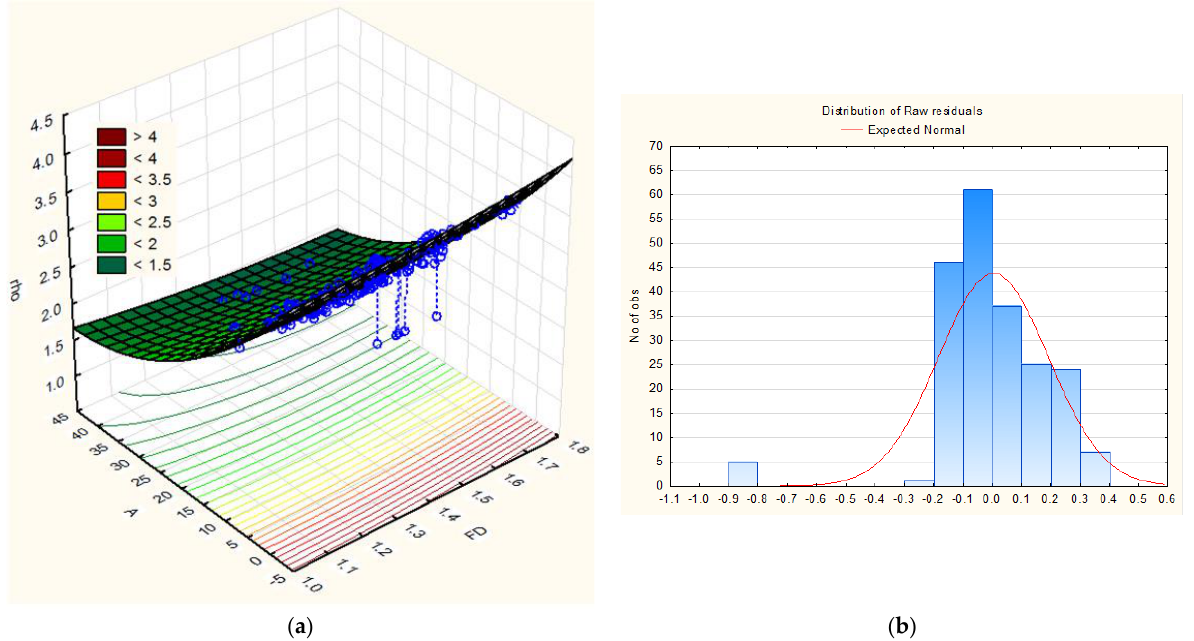
Figure 11. ( a ) Regression surface from fitting ρ = f(FD, A) with a quadratic model (resulted in R 2 = 0.88); ( b ) Residuals recorded by using the derived Equation (3) resulting from fitting.